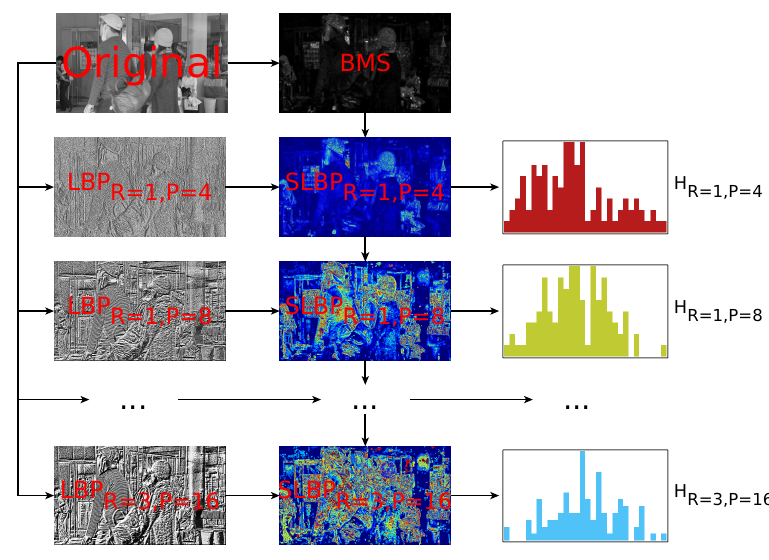
Figure 22. Multiple histogram generation from SLBP.